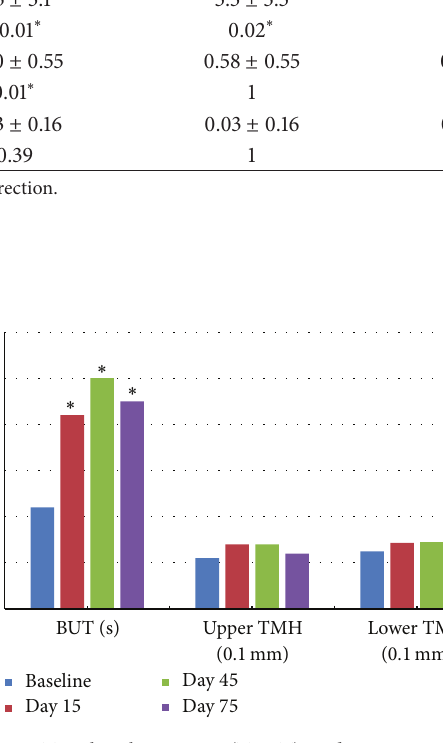
Figure 3: Tear break-up time (TBUT) and tear meniscus